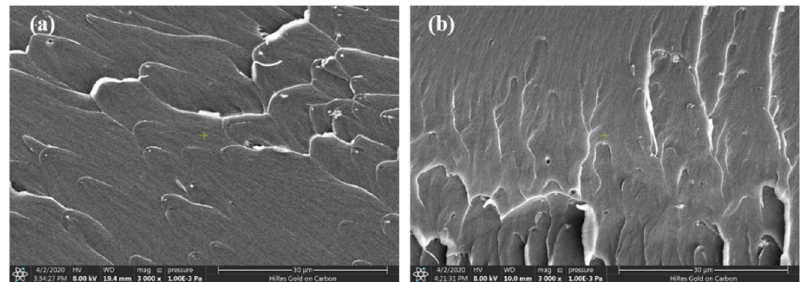
Figure 11. The SEM patterns of the resin surface after isothermal aging at 350 °C for 450 h: ( a ) control;